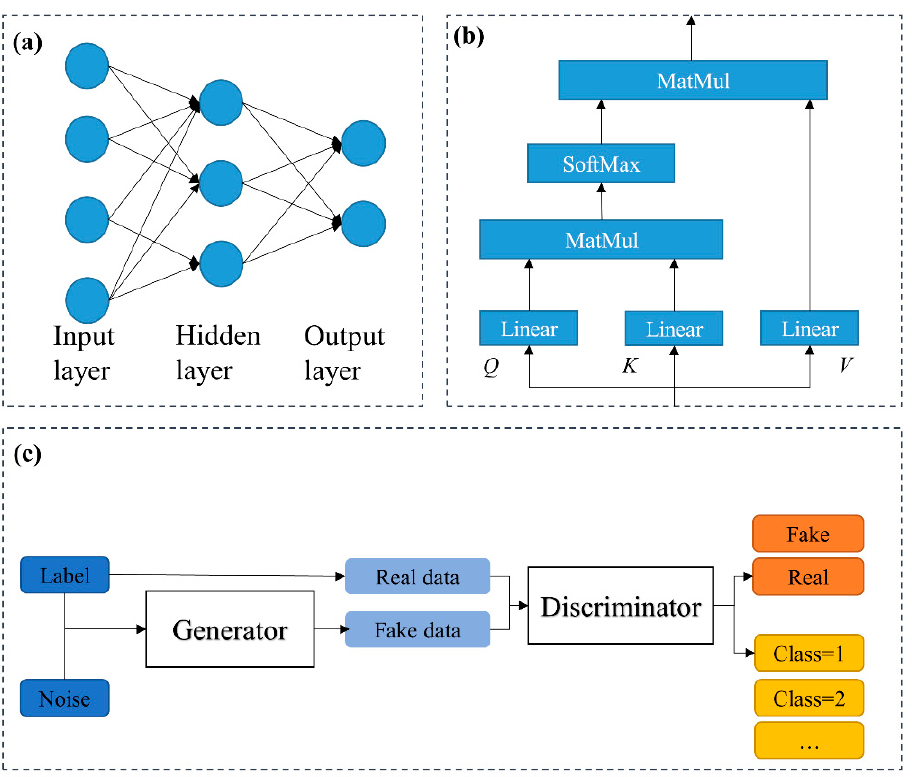
Figure 1. The schematic diagrams of ( a ) an ANN, ( b ) a self-attention mechanism, and ( c ) an auxiliary classifier GAN.